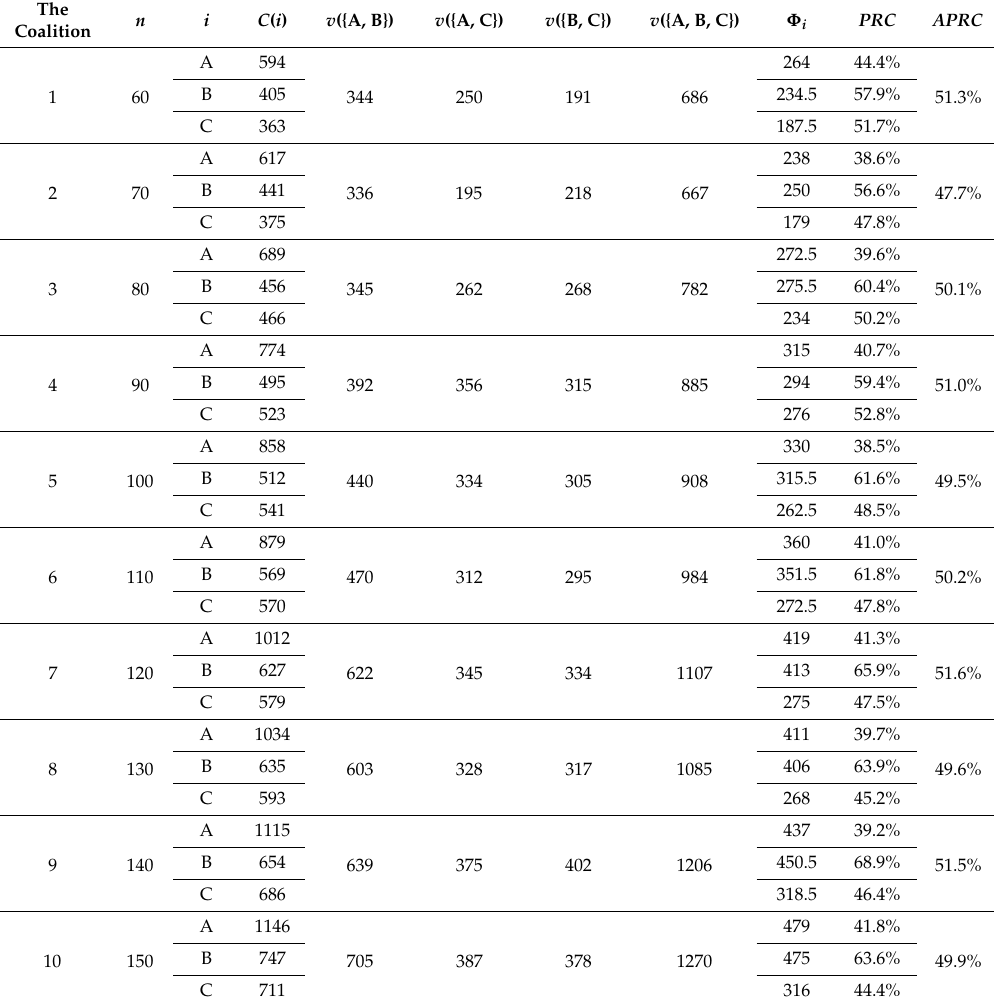
Table 7. The results of profit sharing.